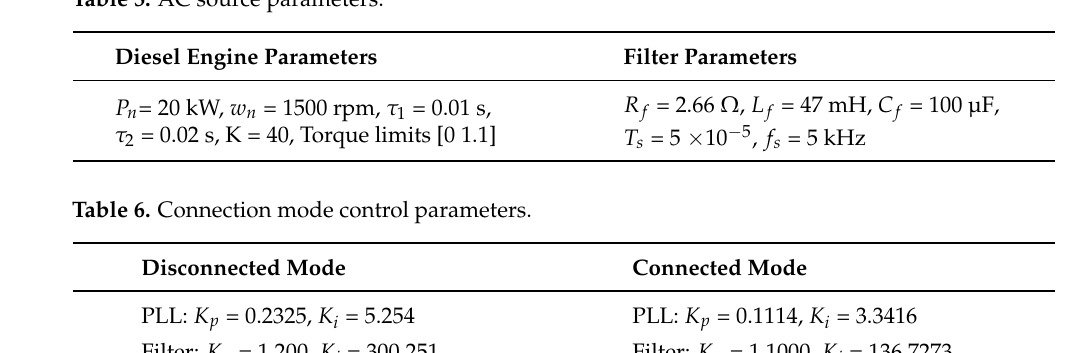
Table 5. AC source parameters.